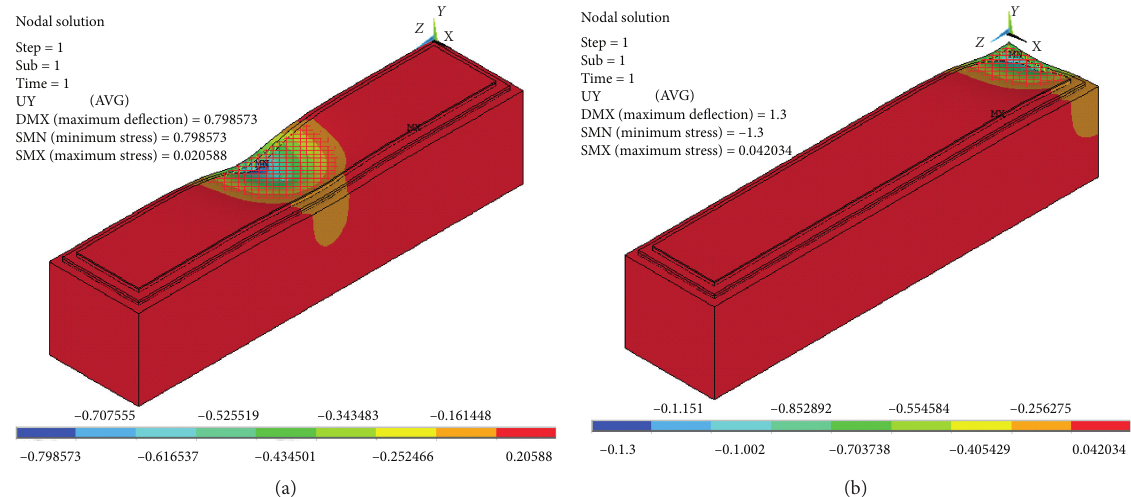
Figure 15: Color-coded deformation plots. (a) The middle of longitudinal seam edge. (b) The slab corners.